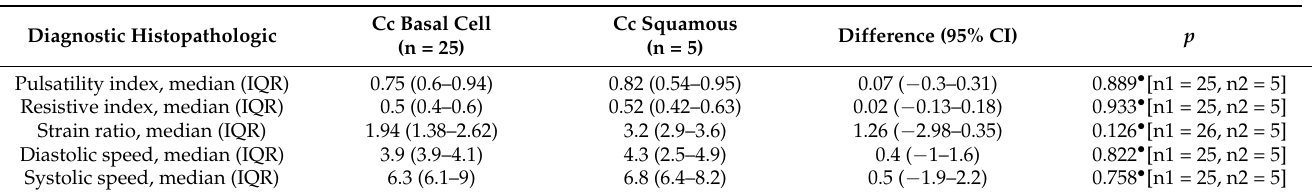
Table 4. Pulsatility index, resistive index, strain ratio, diastolic speed and systolic speed related to histopathological type.